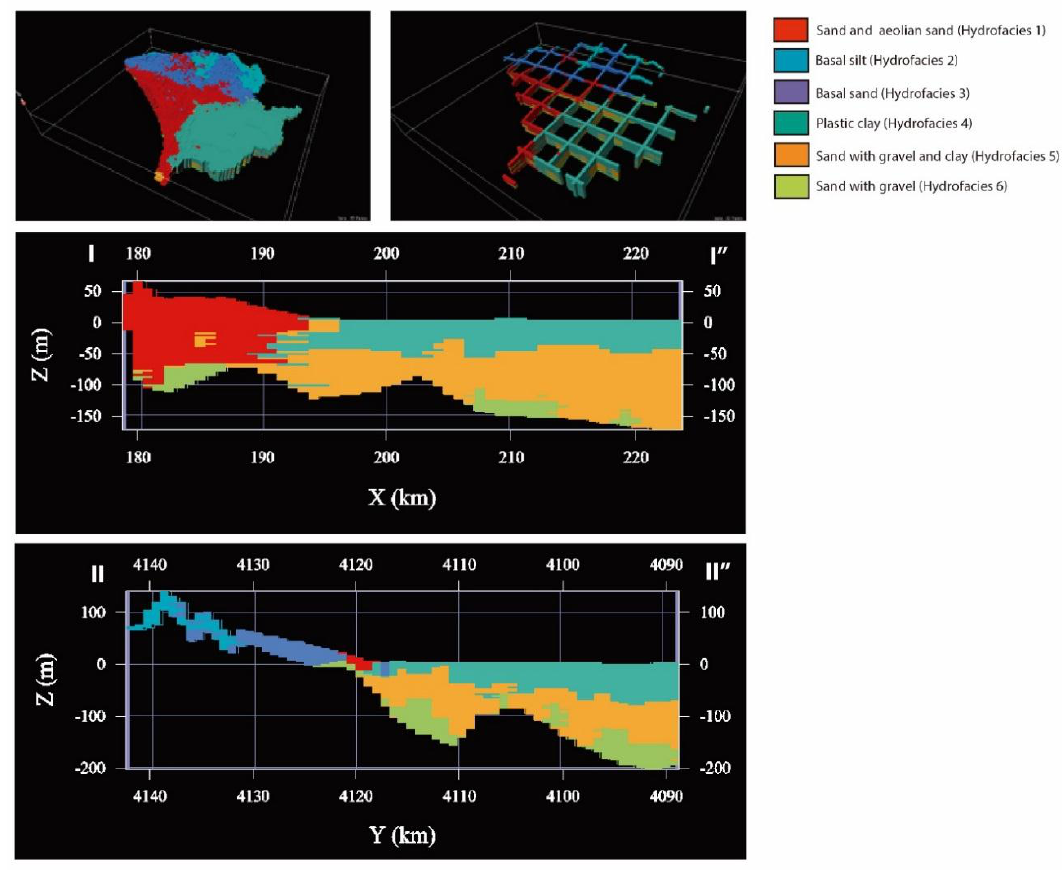
Figure 6. 3D views of SIS results with Isatis 3D Viewer and cross sections I-I’’ and II-II’’.